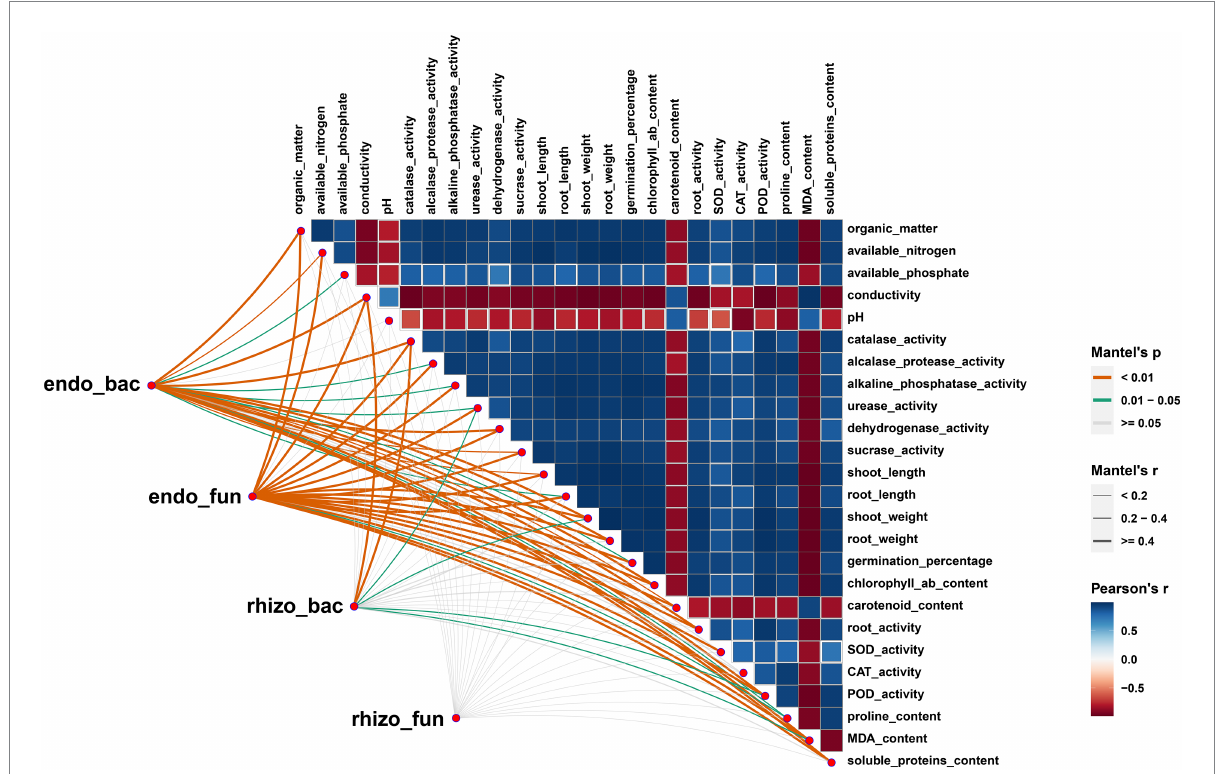
FIGURE 4 Mantel test showed the correlation among root-associate microorganisms, wheat physiology and soil properties. The size of square represents Pearson Correlation Coefficient ( r ) among different physiology properties